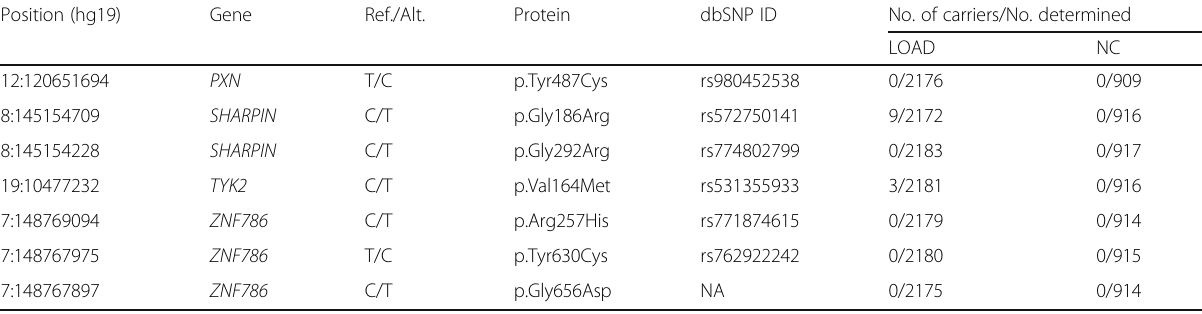
Table 1 Seven candidate risk variants for